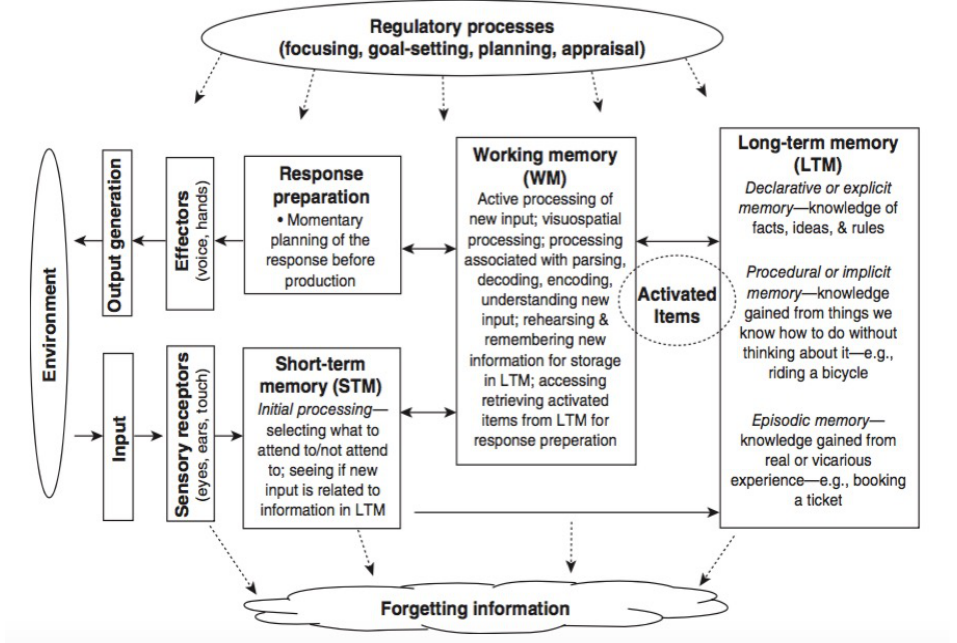
The architecture of human information processing. Adapted from Purpura (2012)